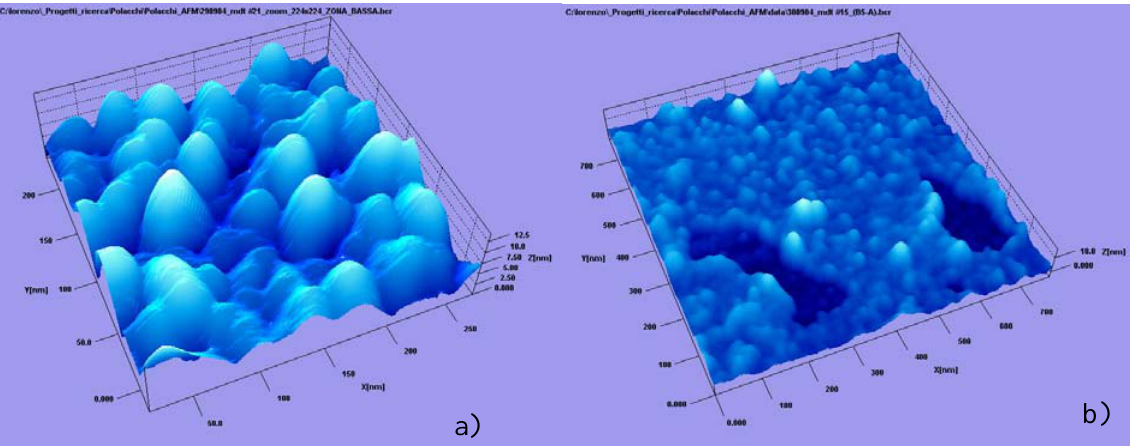
Figure 4. 3D AFM-images for the surface of silicon samples with immobilised enzyme, modified with APTS (a) and GOPS (b).